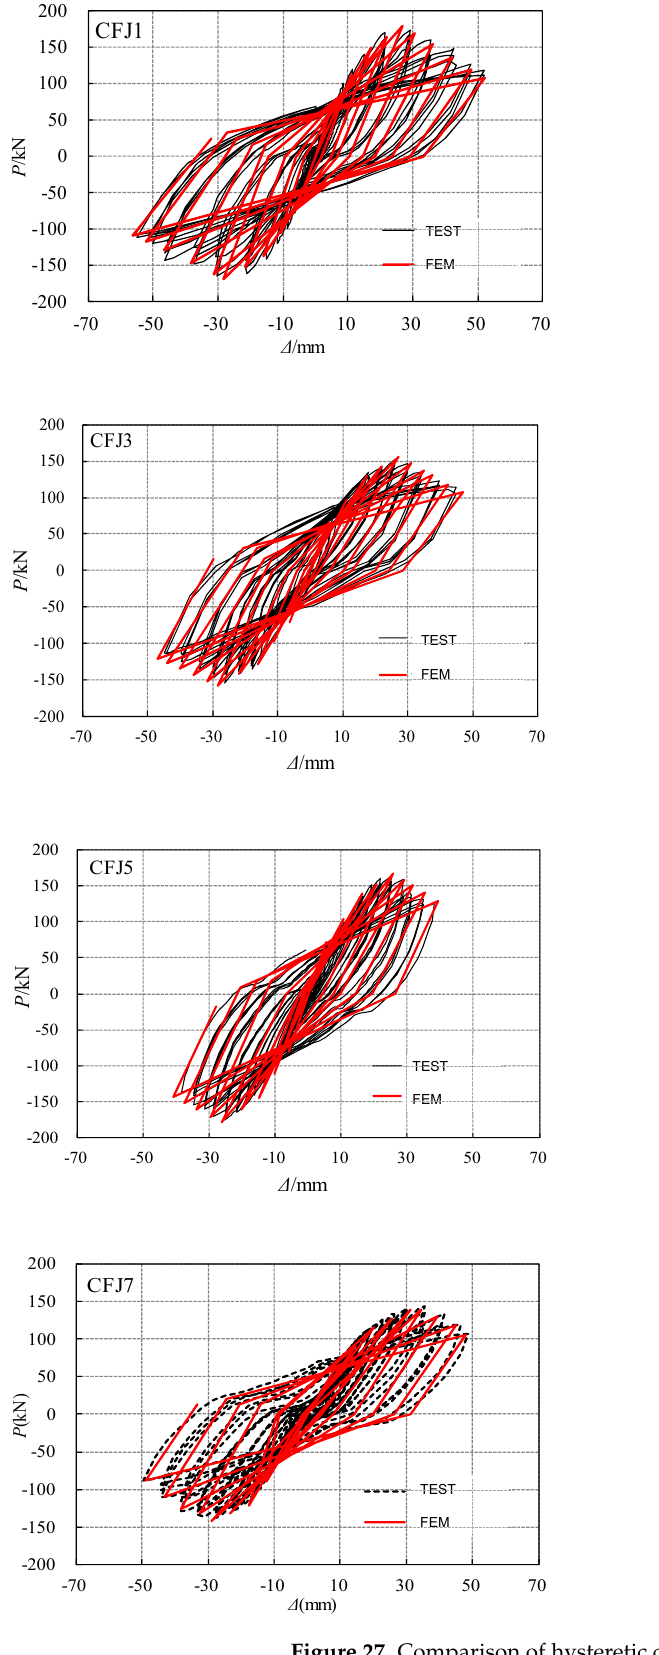
Figure 27. Comparison of hysteretic curve between calculation results and test results.